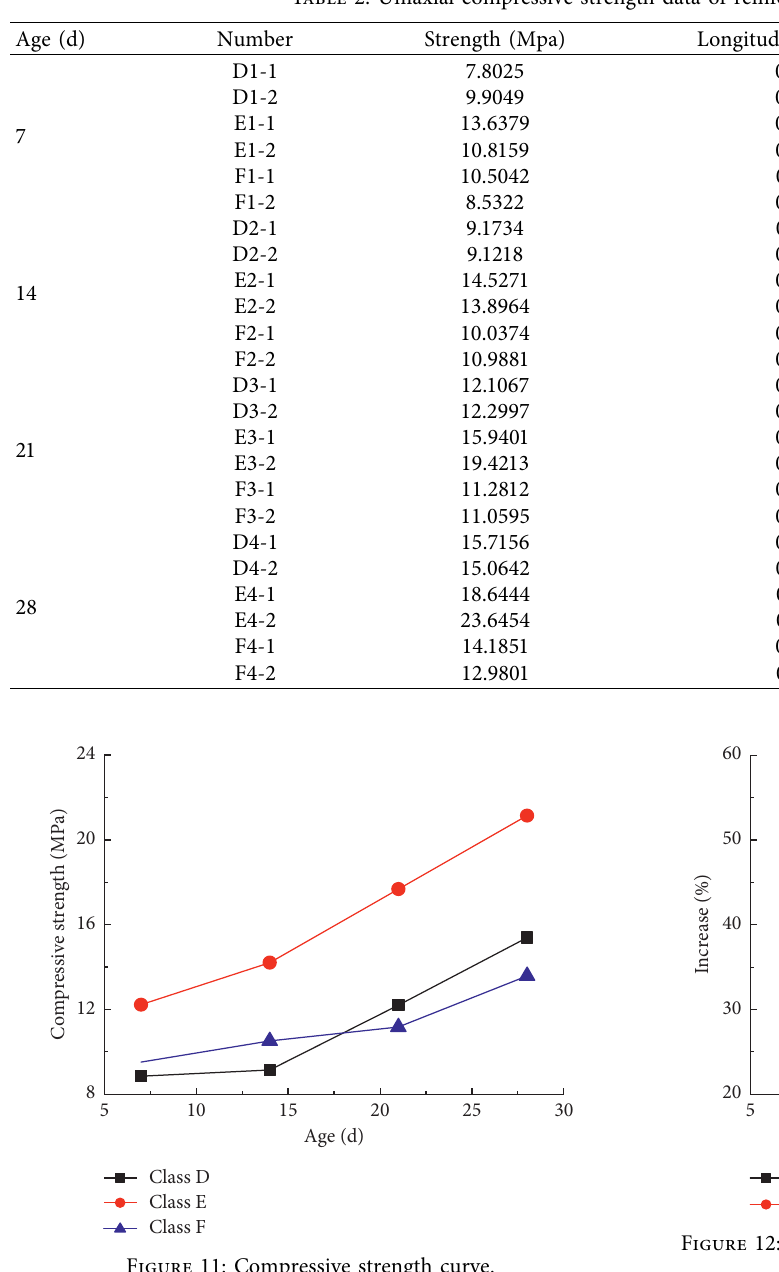
Table 2: Uniaxial compressive strength data of reinforcing cement pastes.